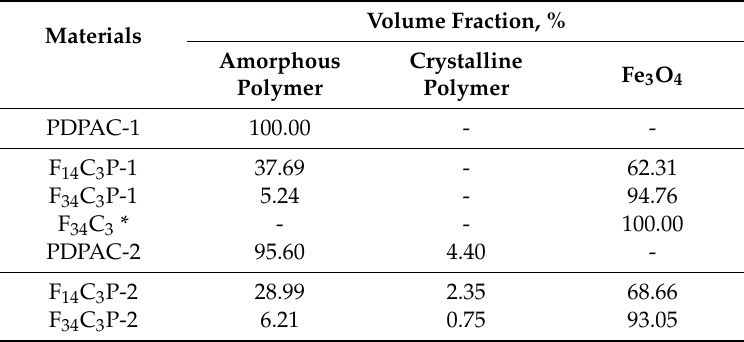
Table 2. Volume fraction of materials.